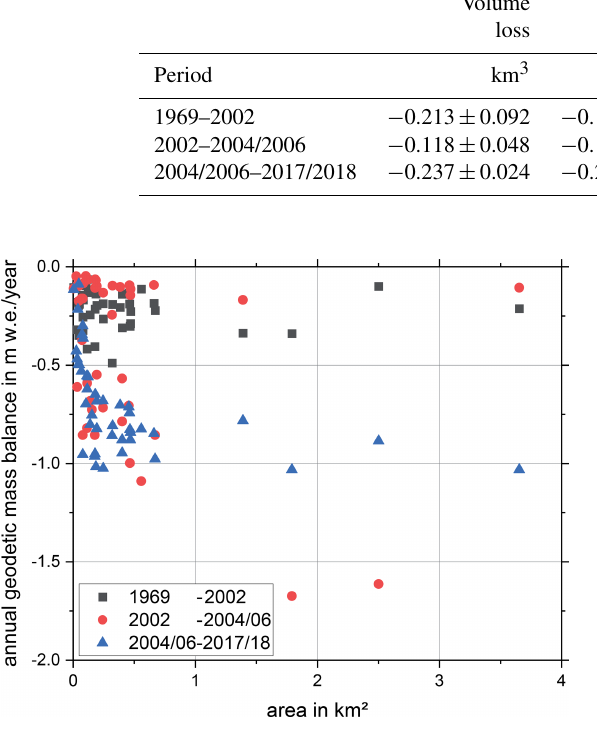
Figure 9. Annual geodetic mass balances for the Austrian Silvretta in 1969–2002, 2002–2004/2006, and